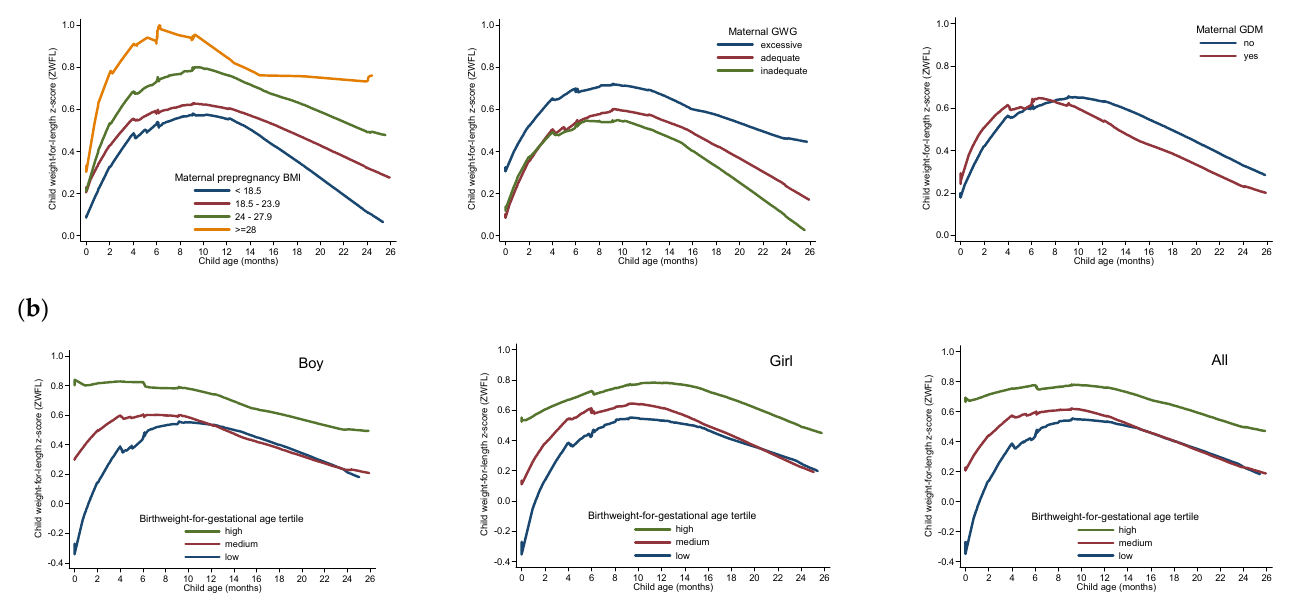
Figure 1. LOWESS regression plot of child weight-for-length z-score (ZWFL) at age 0–2 years in children born appropriate for gestational age (AGA) by ( a ) maternal prepregnancy BMI categories, GWG and GDM status; and ( b ) child birthweight for gestational age tertiles (low, medium, and high) in the total sample and in boys and girls, respectively.